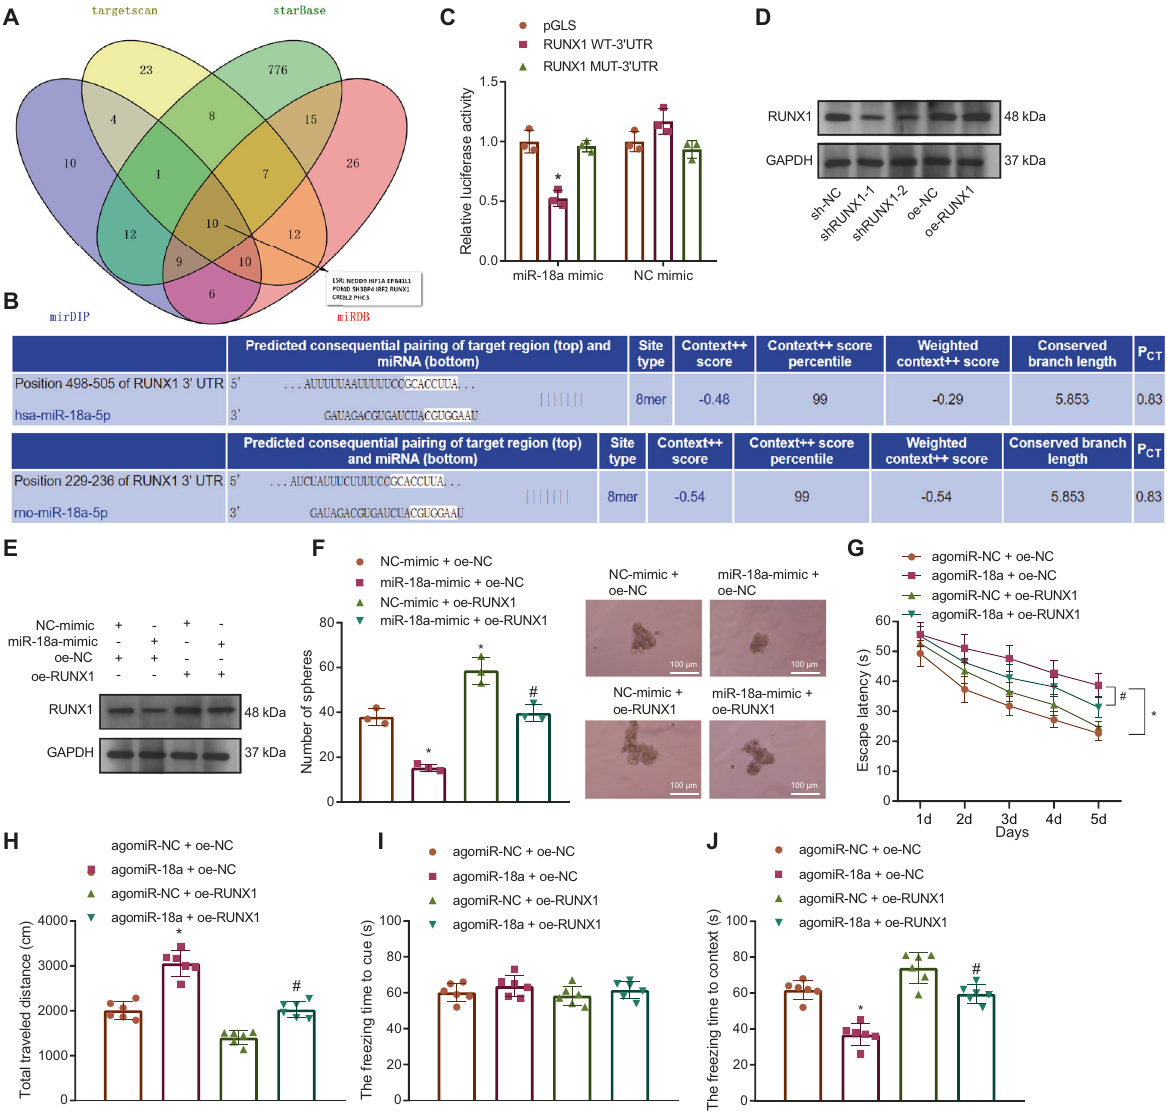
Fig. 3 miR-18a downregulates RUNX1 expression to exert an effect on NSC proliferation and rat neurodevelopment. A Venn diagram displaying the intersection of miR-18a target genes predicted by starBase (http://starbase.sysu.EdUstaining.cn/), targetscan (http:// www.targetscan.org/vert_72/), miRDB (http://mirdb.org/), mirDIP (http://ophid.utoronto.ca/mirDIP/) databases. B The binding sites between miR-18a and RUNX1 in human and rats detected by targetscan database. C The binding between miR-18a and RUNX1 detected by dual- luciferase reporter gene assay. D The expression of RUNX1 after shRUNX1-1, shRUNX1-2 or oe-RUNX1 treatment detected by Western blot analysis. E The expression of RUNX1 after miR-18a-mimic or oe-RUNX1 treatment detected by Western blot analysis. F Intuitive and statistical plots of the NSC sphere-forming ability after miR-18a-mimic or oe-RUNX1 treatment (bar = 100 μ m). G The effect of RUNX1 expression on the movement time of rats in the water maze detected by Morris water maze assay. H The effect of RUNX1 expression on the movement distance of rats in the open fi eld assessed by the open fi eld test. I The effect of RUNX1 expression on the freezing time to cue of rats assessed by conditioned fear test. J The effect of RUNX1 expression on the freezing time to context of rats assessed by conditioned fear test. * p < 0.05 vs. the pGLS/NC-mimic + oe-NC/agomiR-NC + oe-NC group; # p < 0.05 vs. the oe-NC/miR-18a-mimic + oe-NC. n = 6. The cell experiment was repeated 3 times